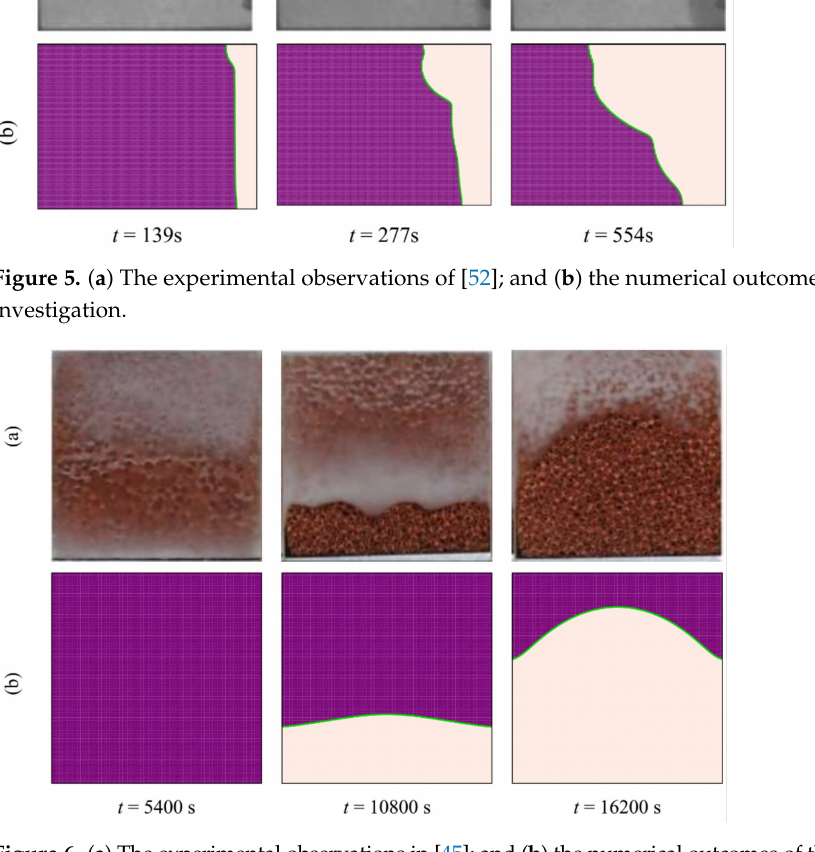
Figure 6. ( a ) The experimental observations in [45]; and ( b ) the numerical outcomes of the present